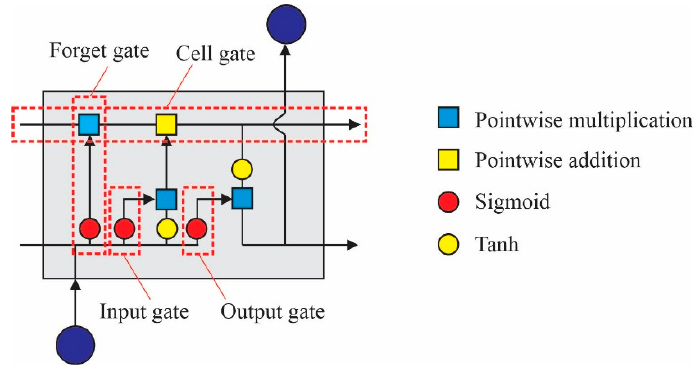
Figure 8. Illustration of an LSTM cell.